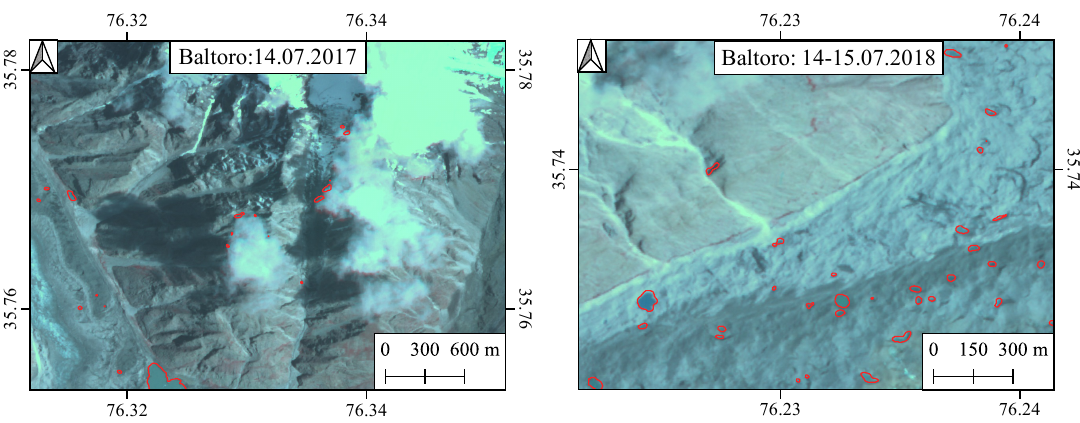
Figure 16. Some misclassification errors were observed in the prediction by the U-Net model. The pixels on the perimeter of the clouds were detected as water pixels. In addition to this some cast shadows have also been detected as water pixels as shown in the image on the